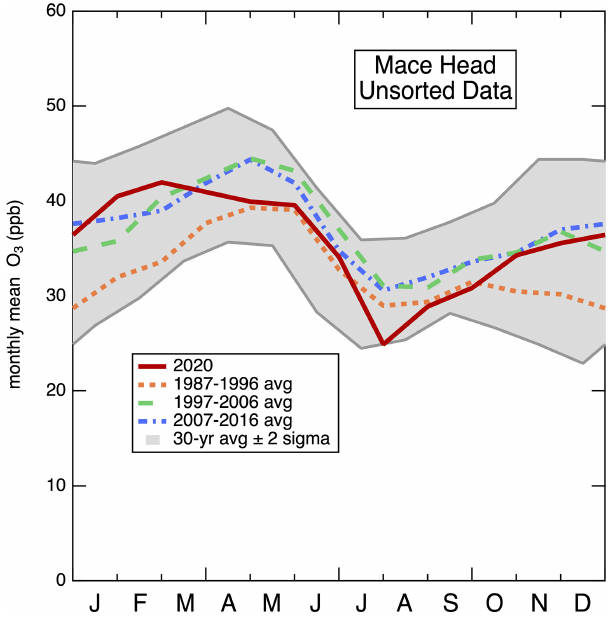
Figure 2. Time series of monthly mean ozone mixing ratios mea- sured at the Mace Head Atmospheric Research Station on the North Atlantic Ocean coastline of Ireland. These data have not been sorted for baseline conditions. The broken curves show the three con- secutive decadal averages: 1987–1996 (dotted orange), 1997–2006 (dashed green) and 2007–2016 (dotted–dashed blue). The shaded region represents the ± 2 σ of the 30-year averages, and the solid dark red line plots the 2020